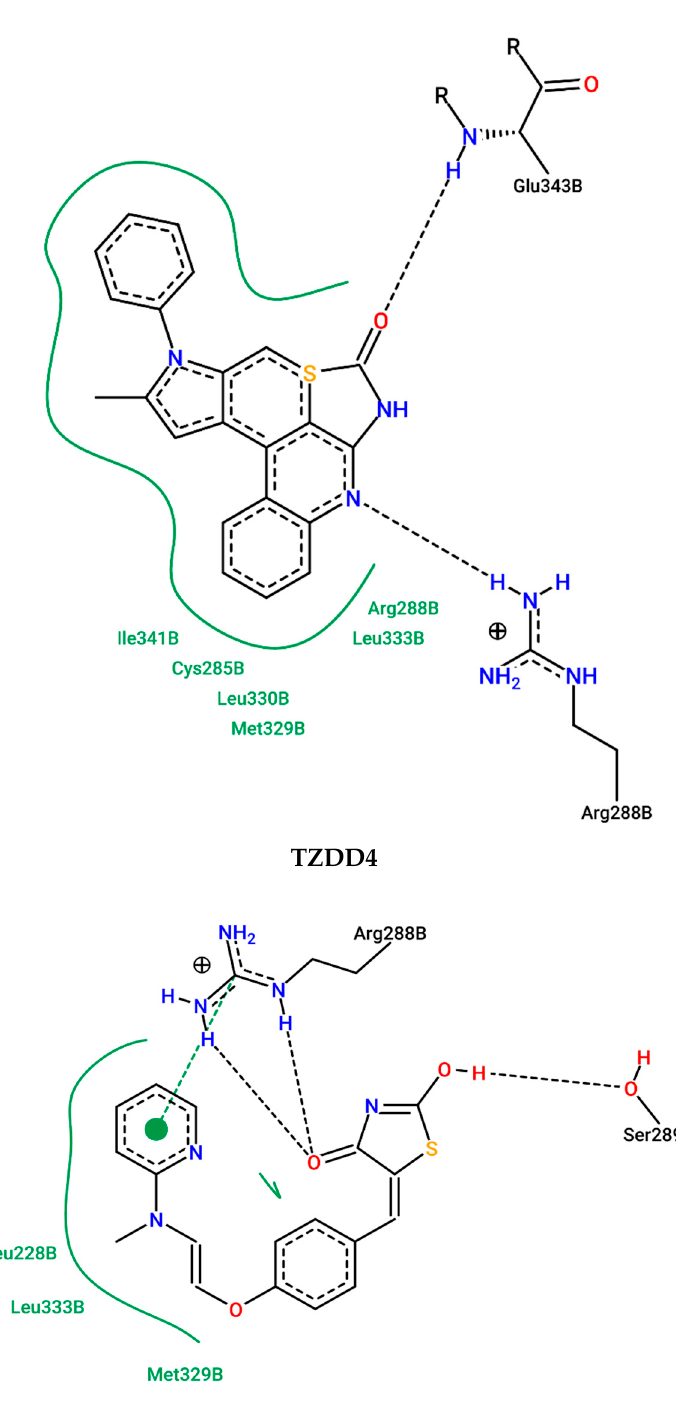
Int. J. Mol. Sci. 2023 , 24 , 3024